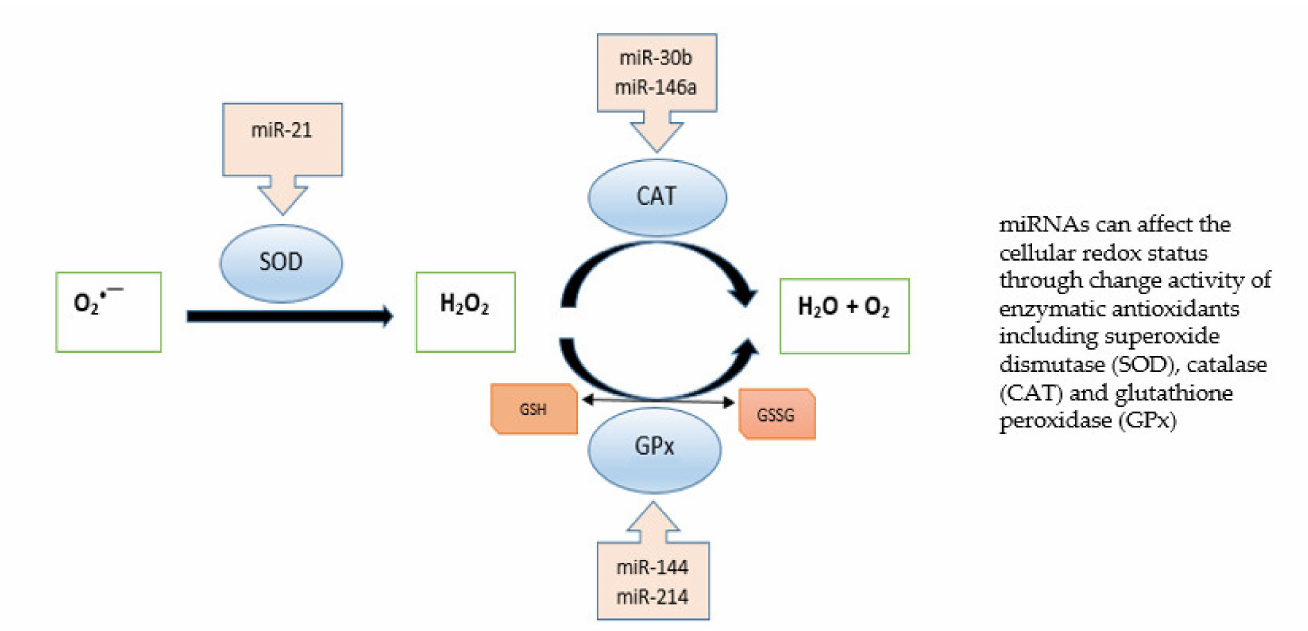
Figure 1. Enzymatic antioxidant capacity and age-related macular degeneration